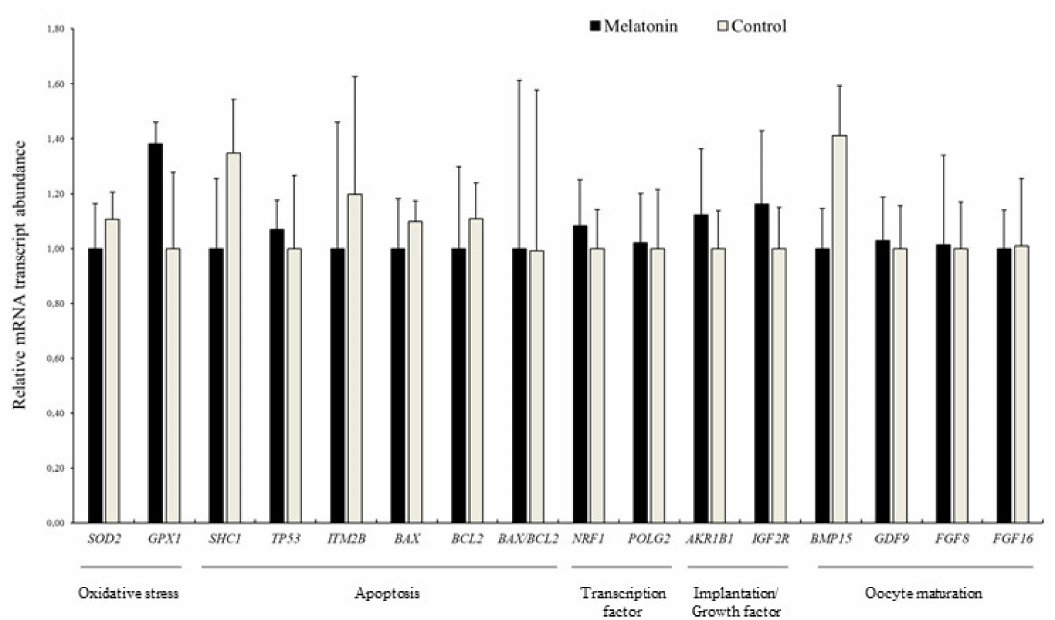
Figure 8. Relative mRNA transcript abundance in Iberian red deer oocytes collected from ovary stored with (Melatonin) and without melatonin (Control); Results are expressed as mean ±